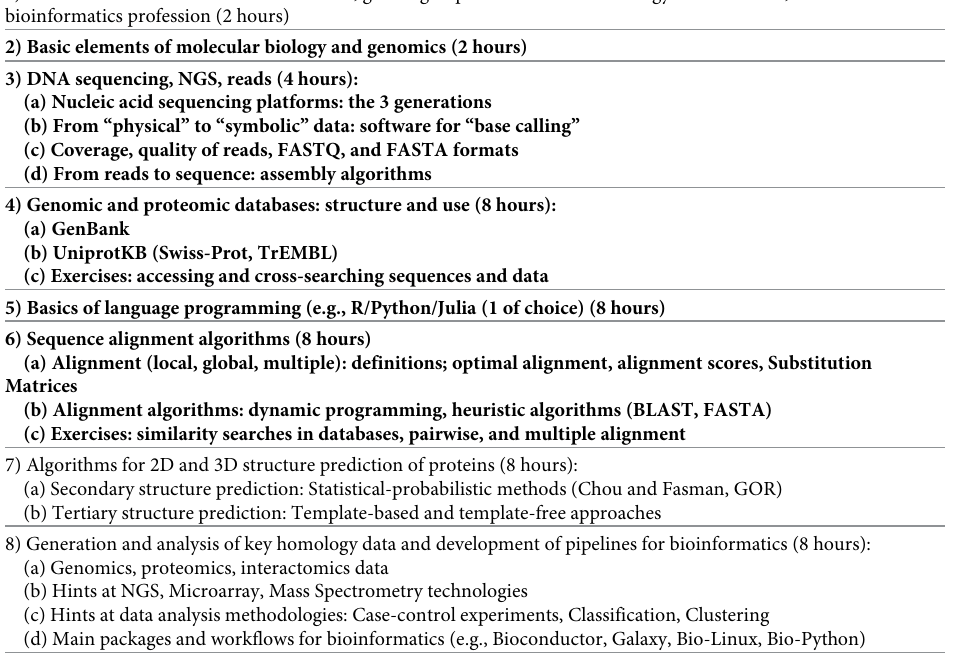
Table 4. Recommended contents for bioinformatics courses embedded in a study path belonging to a BSc degree in computer science-engineering scientific area. 1) Introduction to bioinformatics: rationale, growing importance of data in biology and medicine, the bioinformatics profession (2